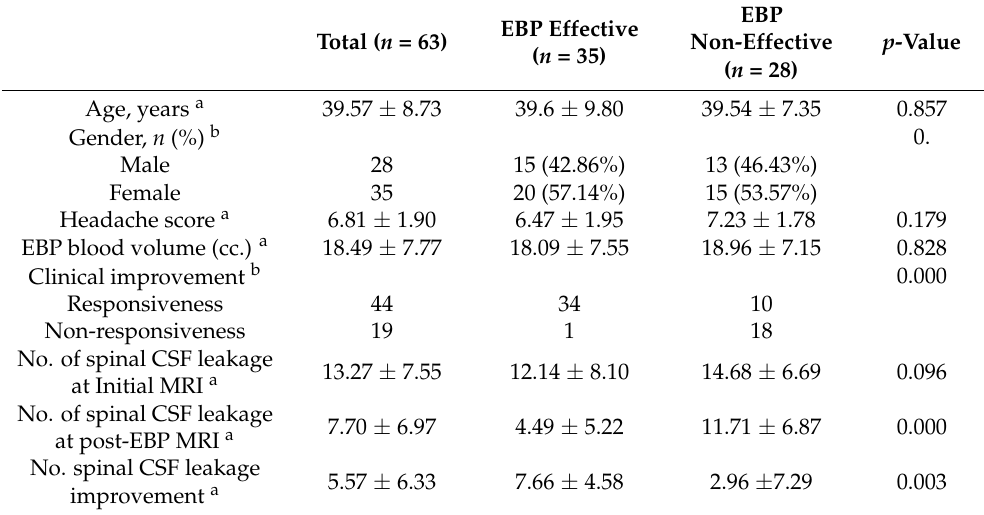
Table 1. Comparison of clinical and initial MRI parameters regarding the effectiveness of